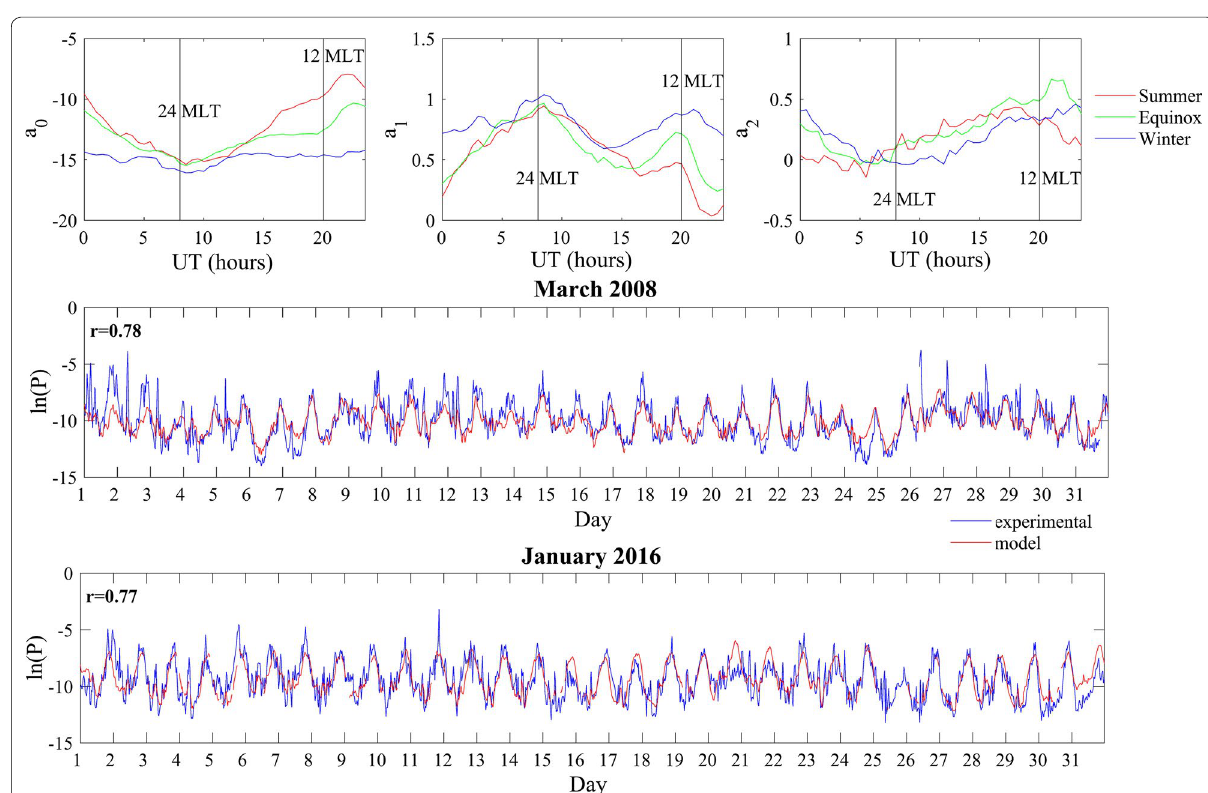
Fig. 11 Pc1–2 power model. Top panels: the UT dependence on model coefficients. Middle and bottom panels: a comparison between experi- mental and model P values for March 2008 and January